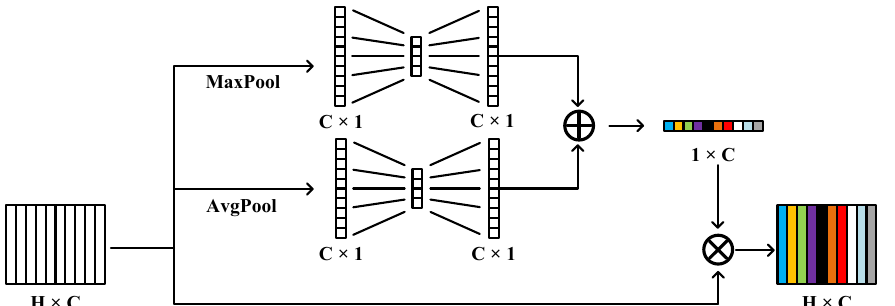
Figure 2. The attention module in the proposed approach. The H × C feature map is firstly reduced to one dimension via two pooling. The two pooling 1D vectors are then inputted to two separate fully connected NNs, respectively. The NNs are used for contribution learning. The outputs of the two NNs are summed to obtained the attention vectors, and are used for feature map weighting.